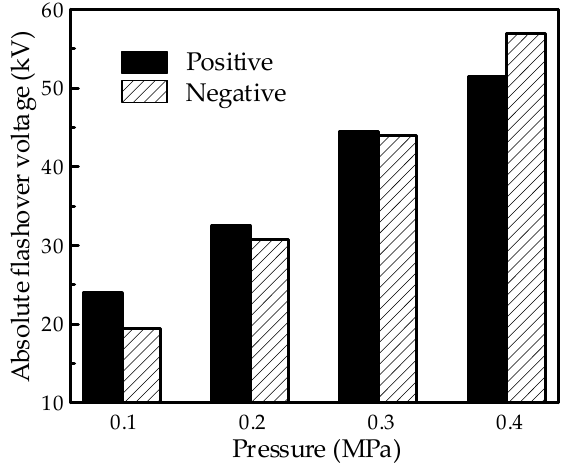
Figure 12. Flashover voltage for needle-plate electrodes under different voltage polarities.